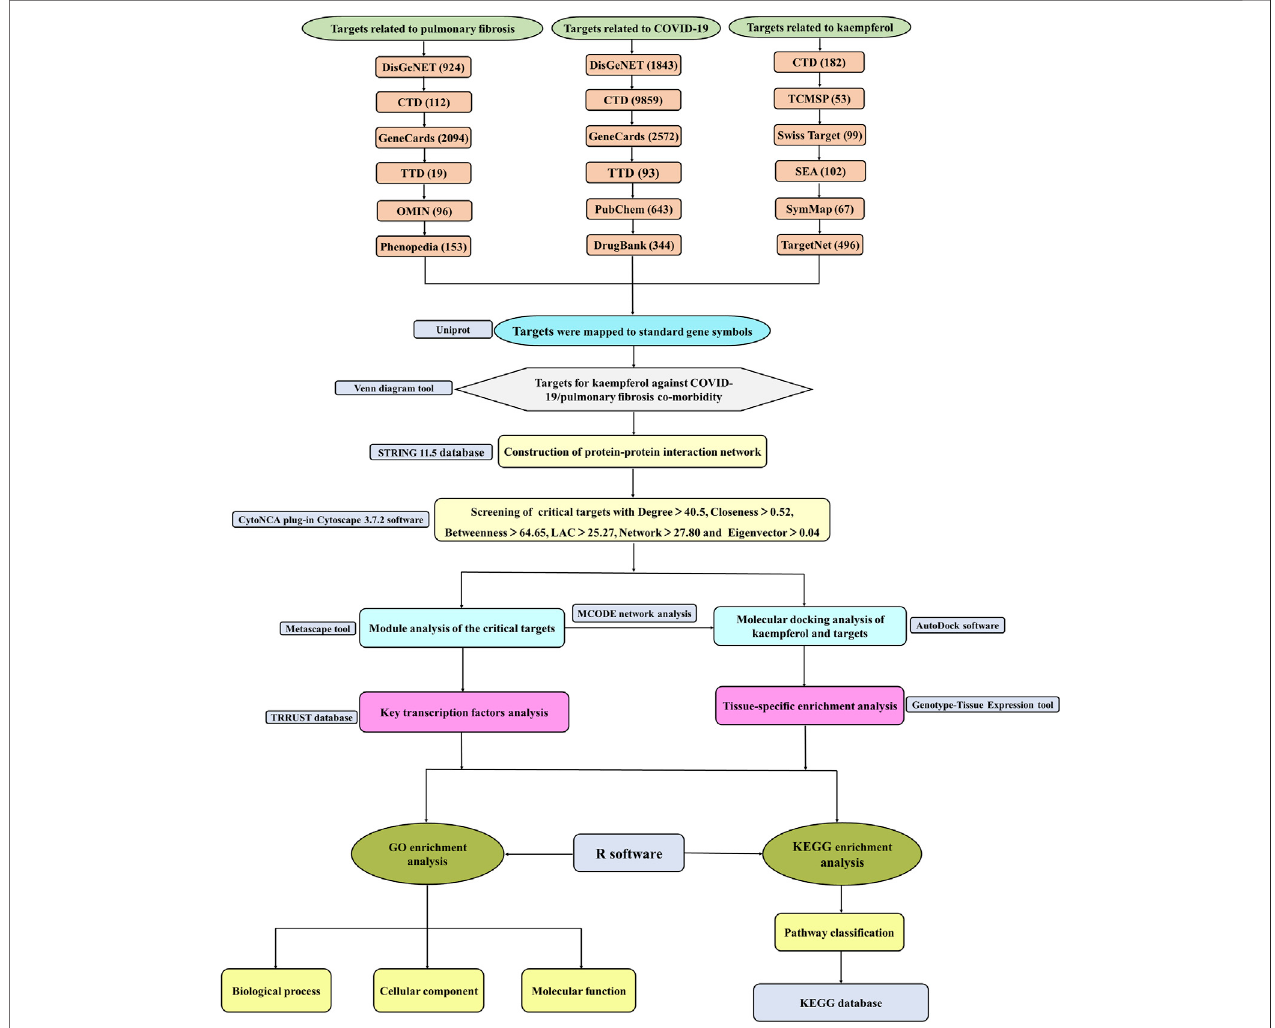
FIGURE 1 | The fl ow diagram of a pragmatic strategy for identifying the pharmacological mechanism of kaempferol against COVID-19/pulmonary fi brosis co- occurrence based on system pharmacology and bioinformatics analysis.